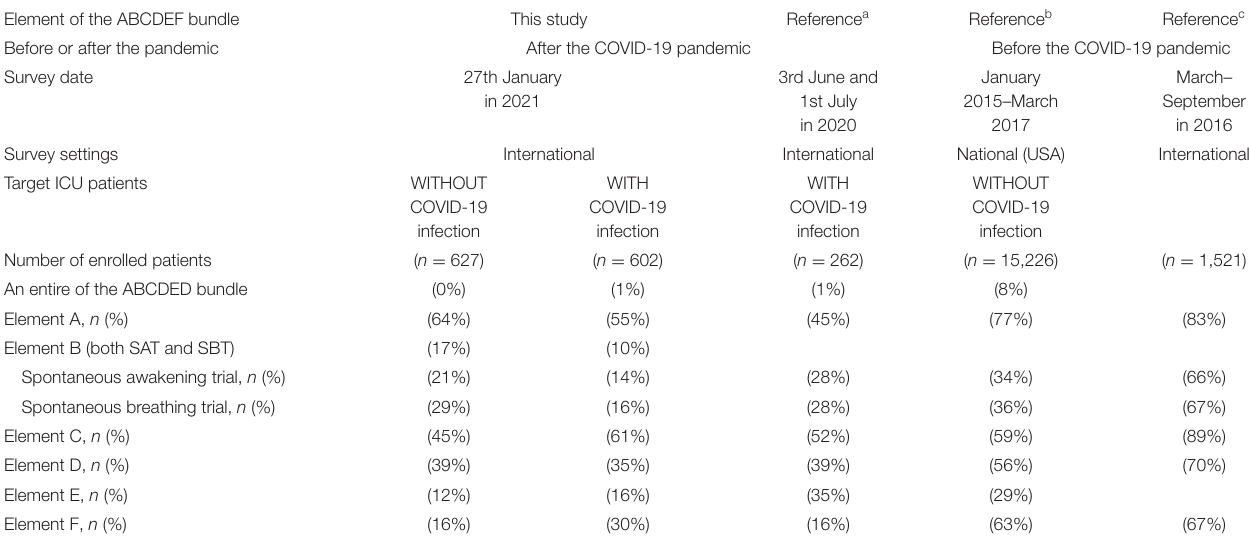
TABLE 5 | Implementation of the ABCDEF bundle compared with previous studies before and after the COVID-19 pandemic. Element of the ABCDEF bundle This